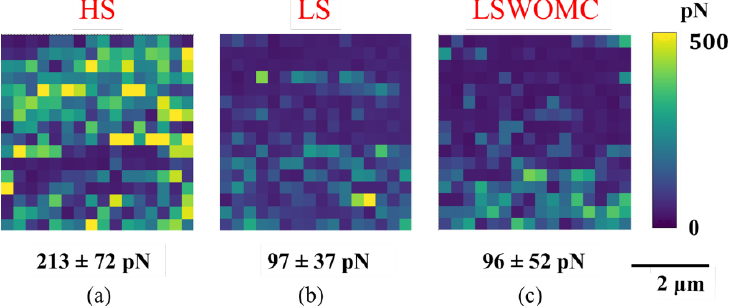
Figure 7. Force volume maps collected over a 5 μm × 5 μm scan area characterizing adhesion of non-polar C 6 H 5 groups to mica substrates in ( a ) HS, ( b ) LS, and ( c ) LSWOMC brine solutions. The mean adhesion force beneath the 16 × 16-pixel maps was based on 256 force curve measurements. A reduction in salt concentration from HS to LS led to a decrease in adhesion force (left to right). However, reducing the concentration of Ca 2+ and Mg 2+ to zero while maintaining same amount of TDS as LS (LSWOMC) did not yield substantial decrease in adhesion force.